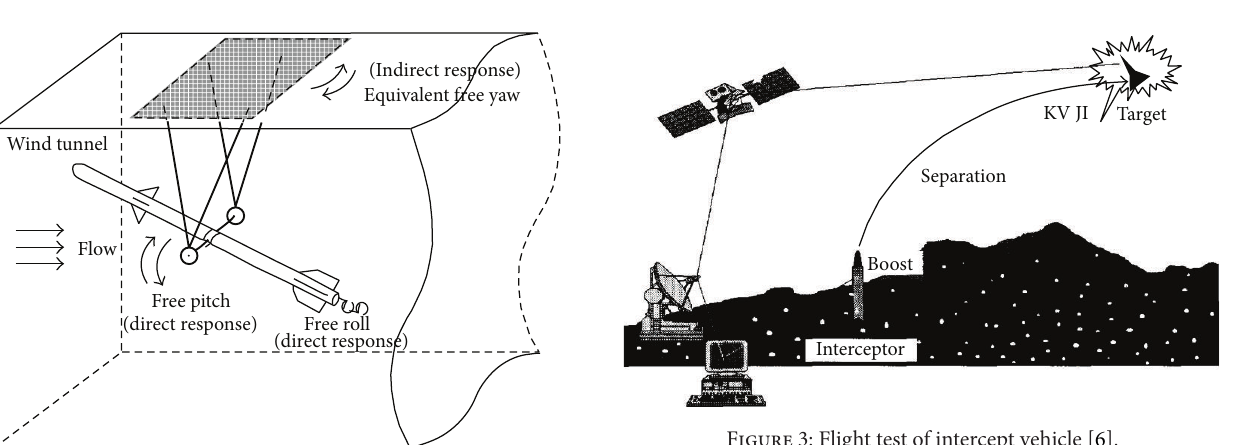
Figure 3: Flight test of intercept vehicle